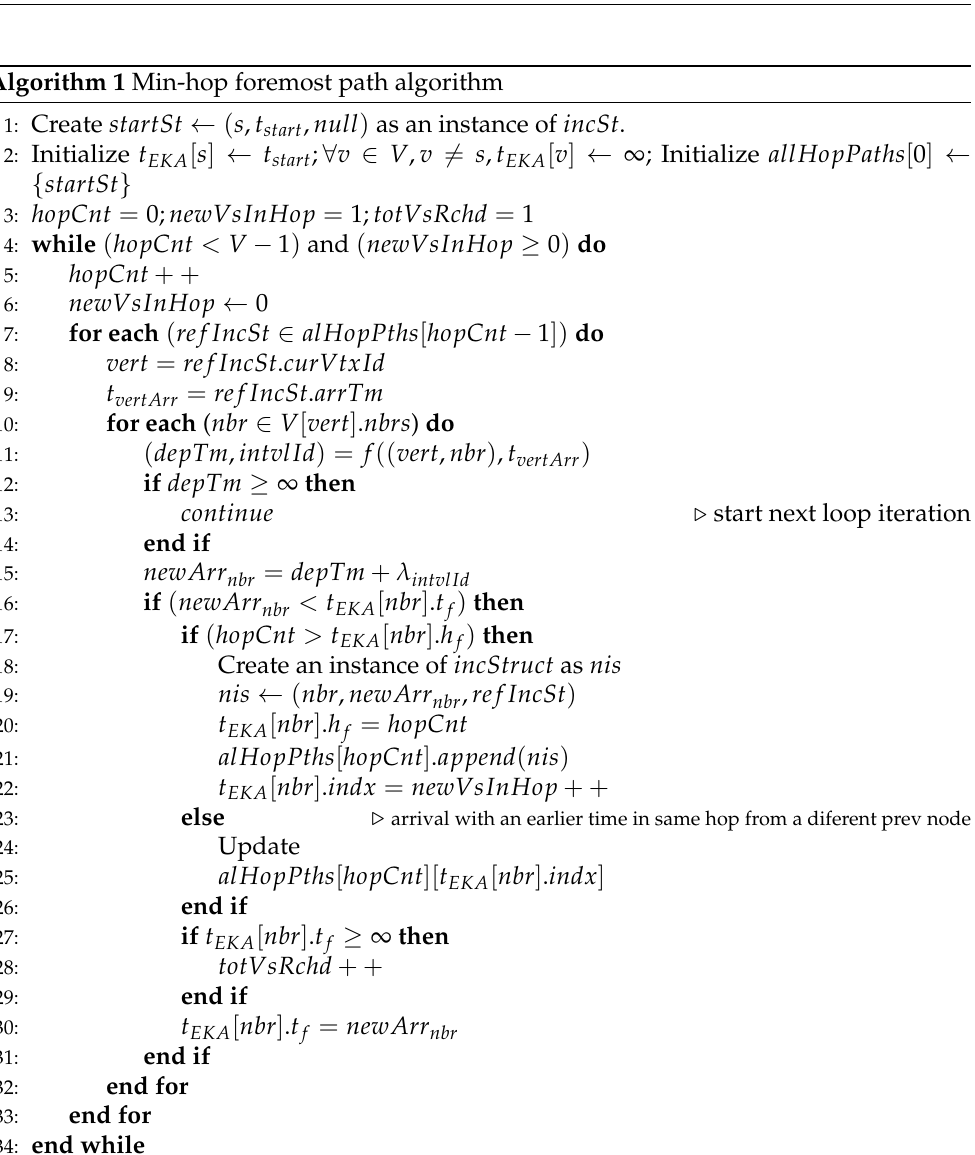
Algorithm 1 Min-hop foremost path